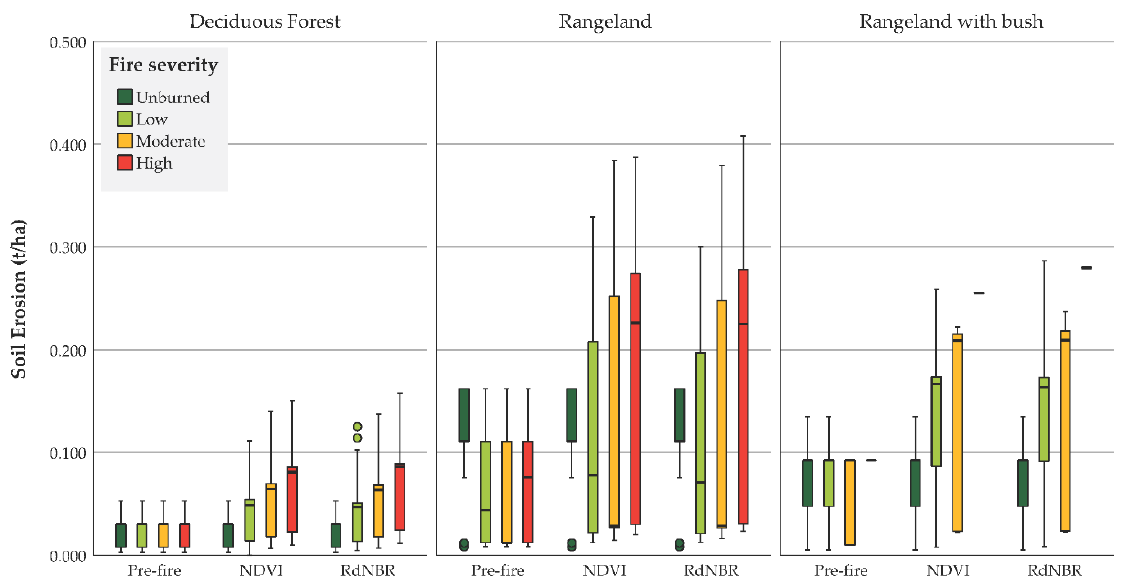
Figure 5. LUC case study: box plots of soil erosion (t/ha) related to the fire severity classification and land use of the three scenarios: Pre-fire, Normalized Difference Vegetation Index (NDVI), and Relative differenced Normalized Burn Index (RdNBR). The horizontal line within the boxes indicates the median; box boundaries indicate the 25th and 75th percentiles; and whiskers indicate the 95th percentile and lowest values of the results.